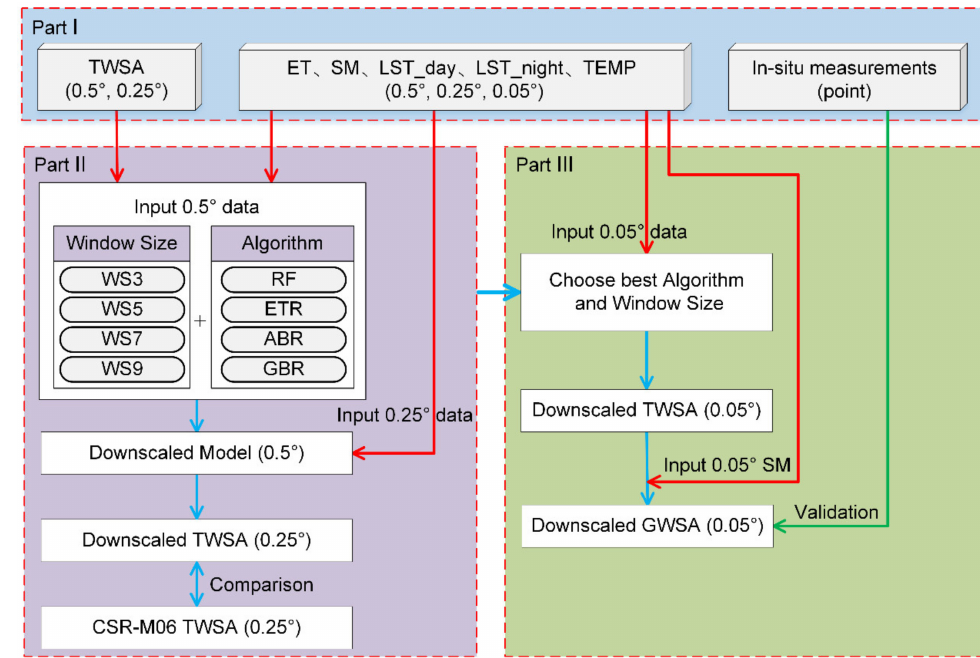
Figure 3. Flowchart of the downscaling